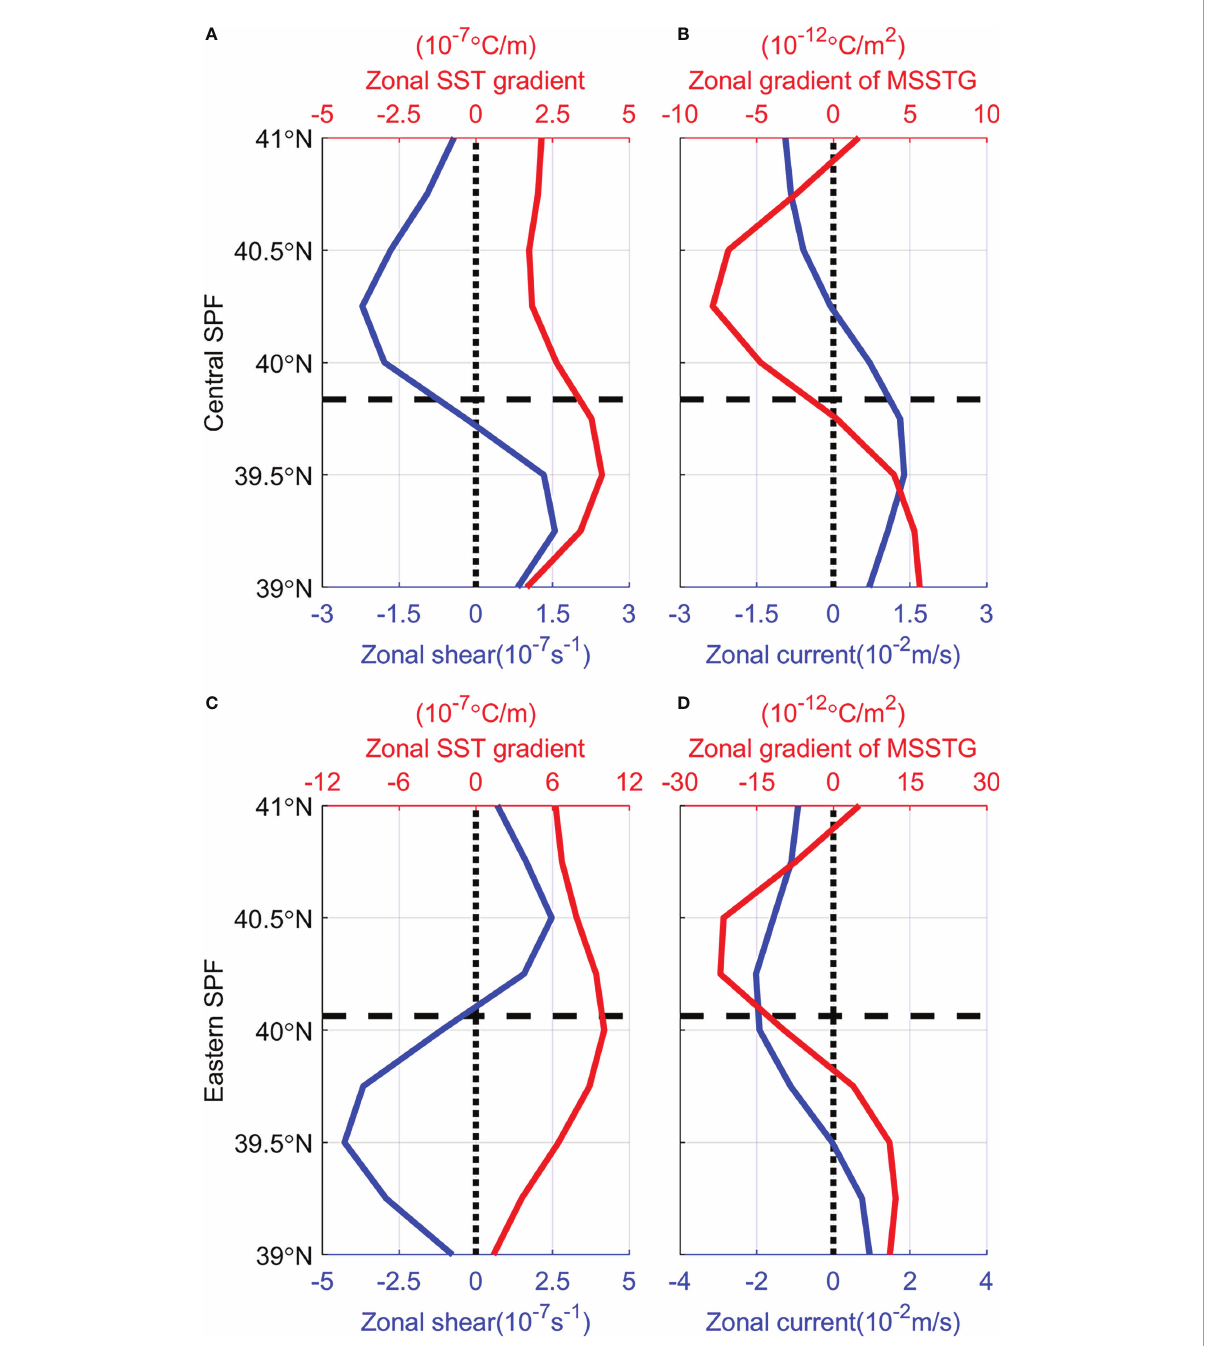
FIGURE 7 (A) Zonal averaged decadal change in the zonal geostrophic shear (blue solid line; unit: 10 -7 s -1 ) and zonal SST gradient (red solid line; unit: 10 -7 ° C/m) for the central SPF. (B) Same as (A) but for the zonal geostrophic current (blue solid line; unit: 10 -2 m/s) and the zonal gradient of the MSSTG (red solid line; unit: 10 -12 °C/m 2 ). Black dashed lines represent the zonal averaged position of the central SPF. (C, D) Same as (A, B) but for the eastern